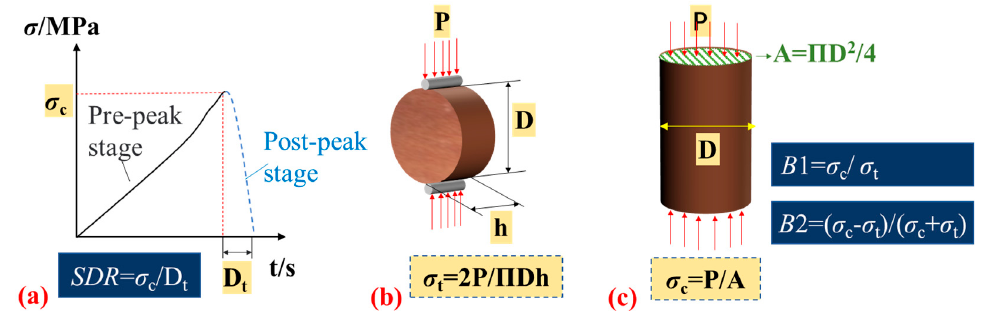
Figure 3. Schematic diagram of the SDR and B calculation process: ( a ) stress-time curve of rocks in uniaxial compression test and determination of SDR , ( b ) determination of σ t ; ( c ) determination of σ c , B 1, and B 2. SDR denotes the strength decrease rate (MPa/s); D t denotes the dynamic failure time in uniaxial compression test (s); σ c denotes the uniaxial compressive strength of rock specimens (MPa); σ t denotes the Brazilian tensile strength of rock specimens (MPa); P denotes the peak load in uniaxial compression test (kN); A denotes the area of the bearing section of a rock specimen (mm 2 ); D denotes the cross sectional diameter of a rock specimen (mm); h denotes the height of the rock specimen (mm).